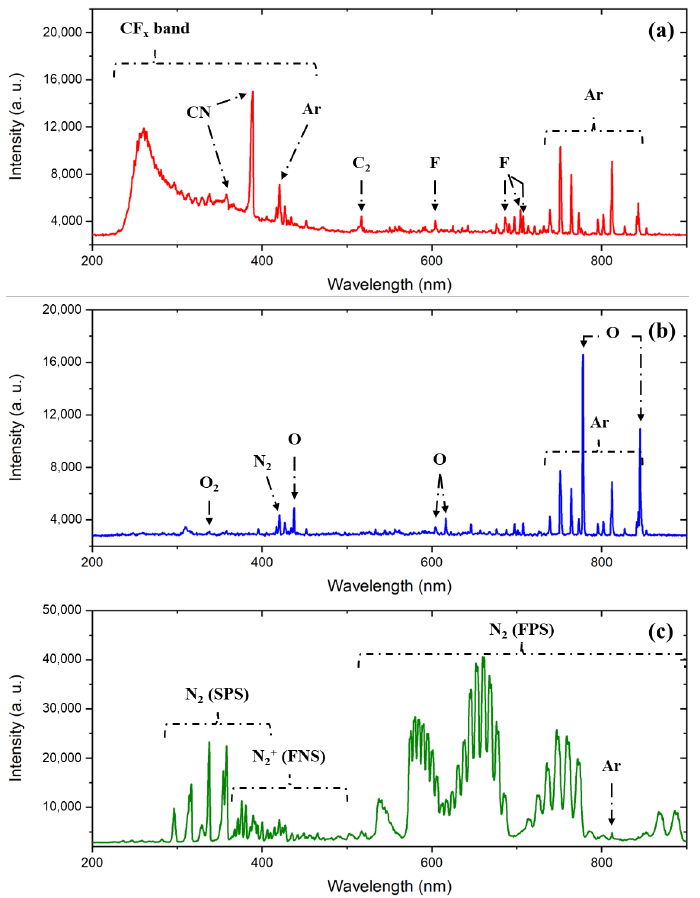
Figure 4. ( a ) CF 4 , ( b ) O 2 , and ( c ) N 2 OES spectrum. N 2 -related peaks in ( a ) and ( b ) appeared due to air leakage.